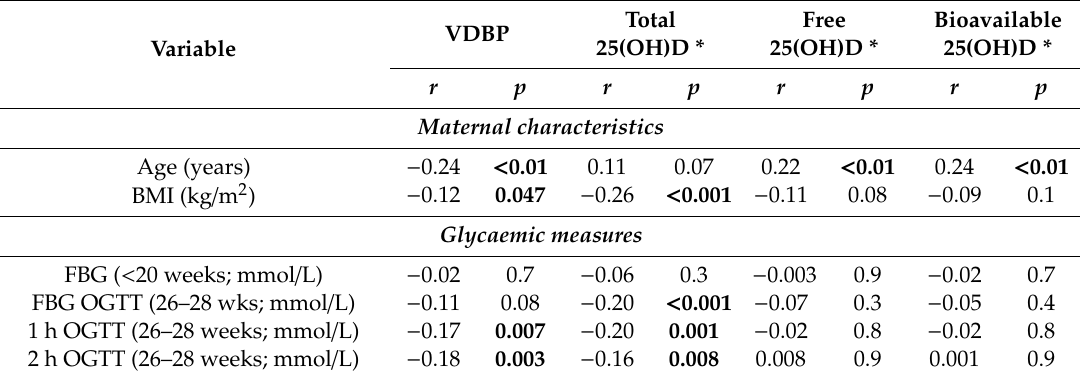
Table 4. Pearson correlations between vitamin D metabolites and maternal characteristics and glycaemic